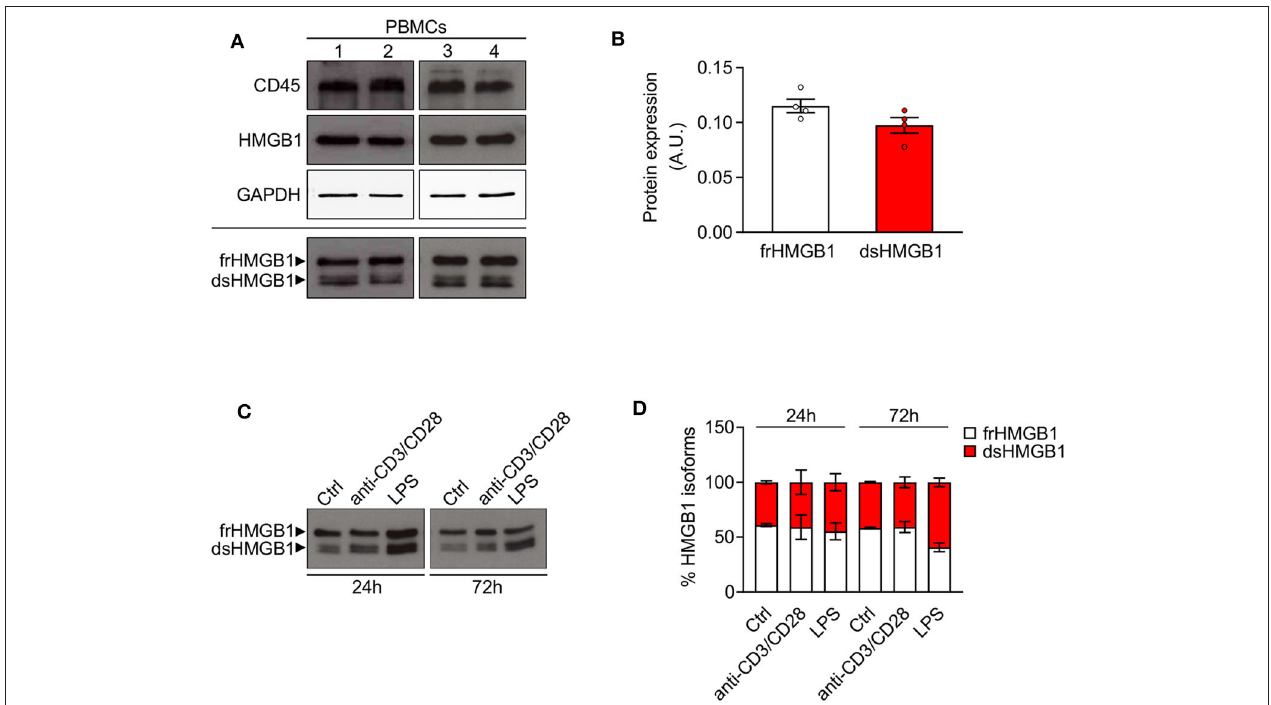
FIGURE 3 | High expression of disulphide-HMGB1 in human leukocytes. (A) Western blot probed with anti-CD45, anti-HMGB1, and anti-GAPDH antibodies in reducing conditions (upper panels) or probed with anti-HMGB1 antibody in non-reducing conditions (lower panel) on peripheral blood mononuclear cells (PBMCs) isolated from four healthy human donors. The upper band corresponds to the fully reduced-HMGB1 (frHMGB1) and the lower band to the disulphide-HMGB1 (dsHMGB1) in the lower panel. (B) Quantification of HMGB1 redox isoforms expression normalized on Ponceau staining. A.U. = arbitrary unit ( n = 4 healthy donors). (C,D) Western blot probed with anti-HMGB1 antibody in non-reducing conditions on PBMCs stimulated with anti-CD3/anti-CD28 antibodies or lipopolysaccharide (LPS) for 24 or 72h (C) . Percentage of HMGB1 redox isoforms expression (D) . Ctrl, control unstimulated cells ( n = 2 healthy donors). Data represent the means ± SEM and statistical significance was calculated by Two-way ANOVA (D)